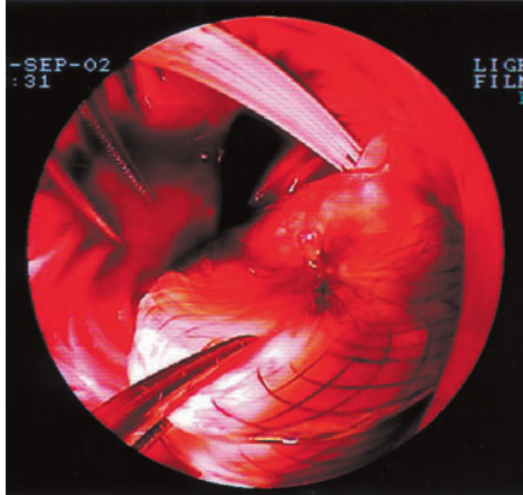
Endoscopic view of a displaced atrial septal occluder (Amplatzer) with both lips in the right atrium (bottom) during surgical re- moval through a right mini-thoracotomy with subsequent suture